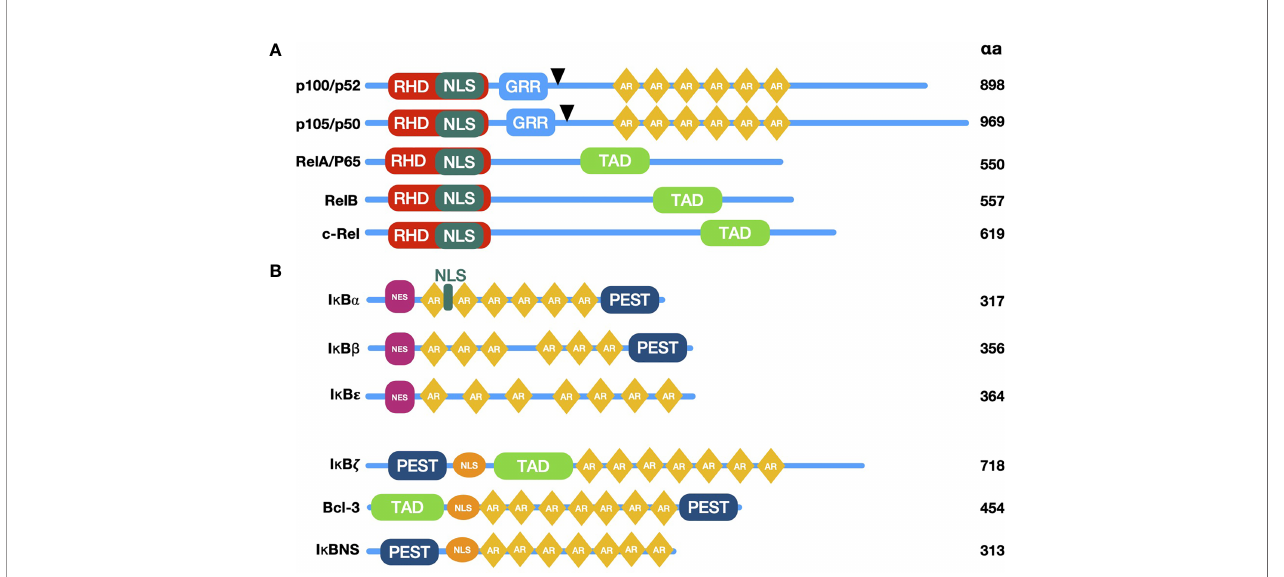
FIGURE 1 | Schematic diagram of NF- k B and I k B family members. (A) The proteins p100 and p105 are the precursors of p52 and p50; they lack transactivation domain (TAD), which bind to other proteins such as transcription factors coregulators. Black arrowheads are pointing to C terminal proteolytic cleavage sites originating p52 and p50. NF- k B family proteins contain sequences required for DNA binding, dimerization, and nuclear localization, called Rel Homology Domain (RHD). (B) Typical and Atypical members of the NF- k B inhibitors (I k B) family are characterized by the presence of Ankyrin Repeats (AR) and their ability to bind and sequester NF- k B dimers in the cytoplasm (typical members) or recruit them to speci fi c gene promoters in the nucleus (atypical members). RHD, Rel homology domain; TAD, transactivation domain; GRR, glycine-rich region; AR, ankyrin repeats; PEST, proline-, glutamic acid-, serine threonine-rich sequence; NLS, Nuclear Localization Signal; NES, Nuclear Export